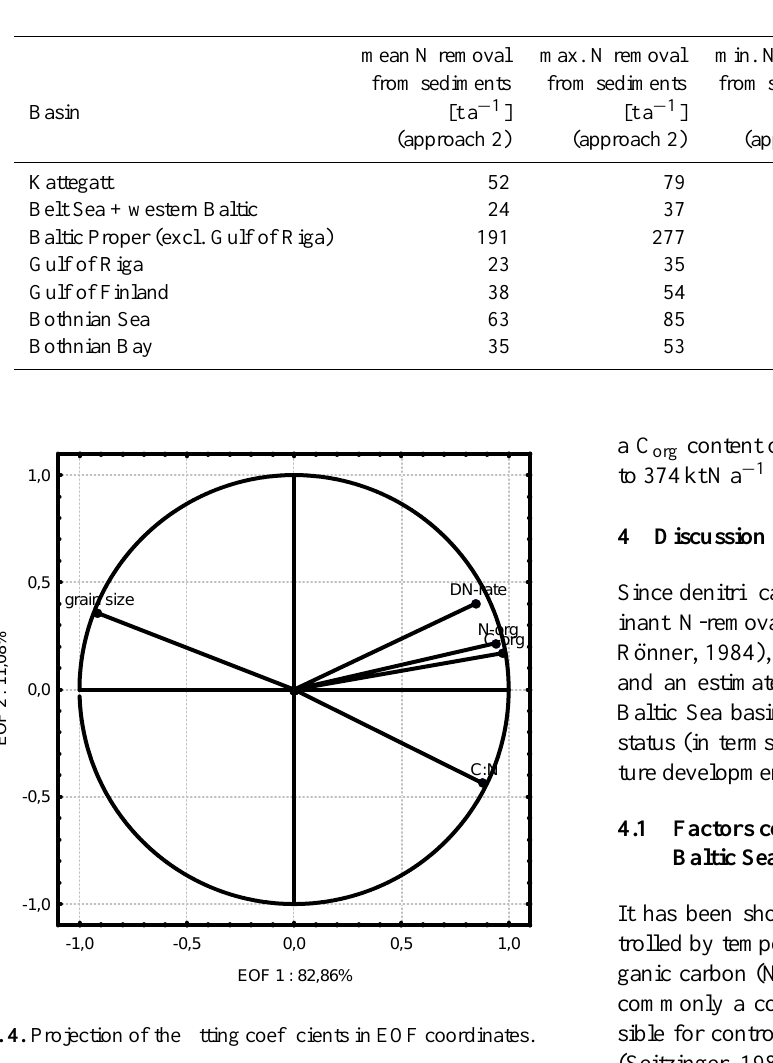
Table 4. N-removal via sedimentary denitrification per basin calculated via approaches 2 (oxycline at 100m) and 3 (oxycline at 80m) and the reduction of the N-removal as a result of a rise of the oxycline (mean N-removal from approach 2 minus mean N-removal from approach 3).